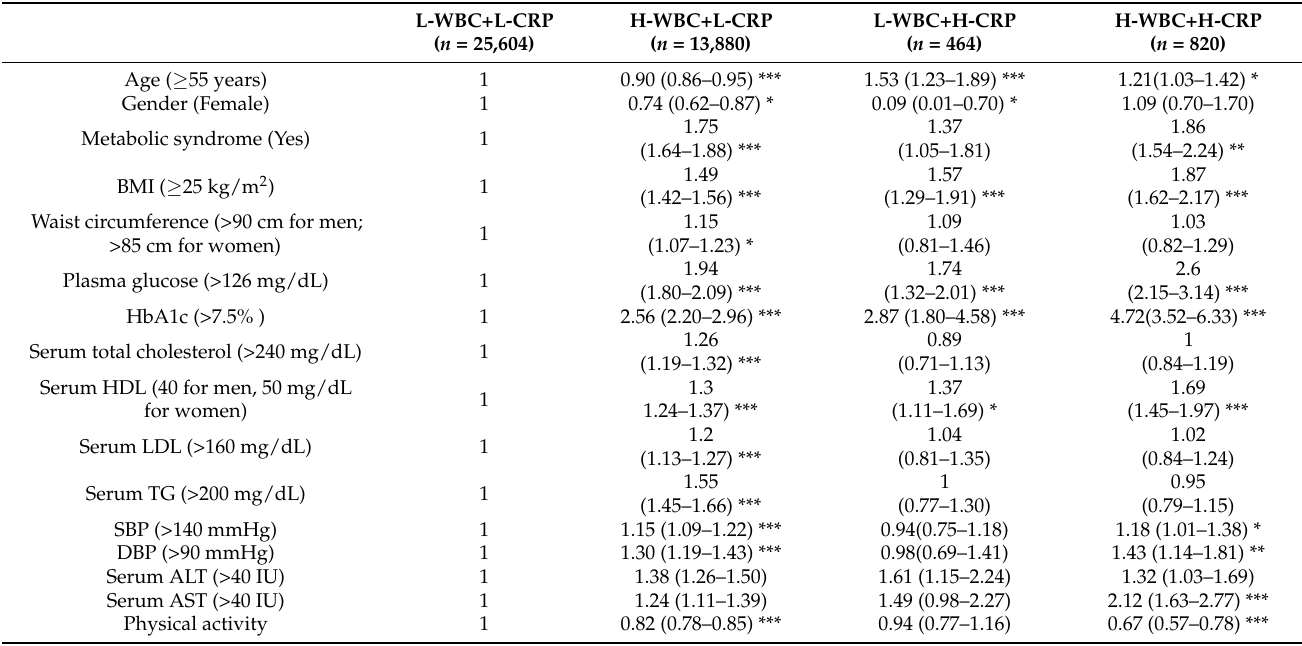
Table 3. Adjusted odds ratio and 95% confidence intervals for metabolic syndrome and various metabolic-related parameters by innate immunity